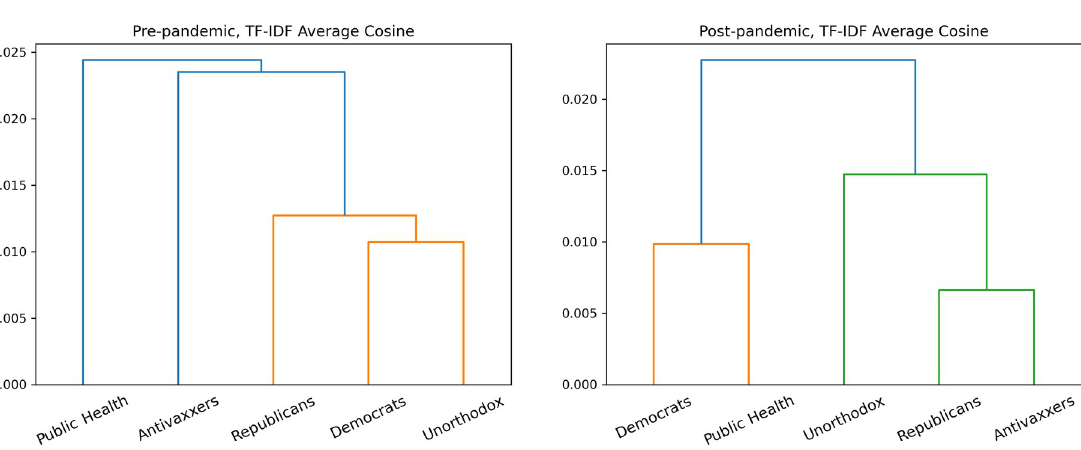
Fig 3. Dendrogram showing hierarchical clustering for pre- and post-declaration tf-idf vectors.